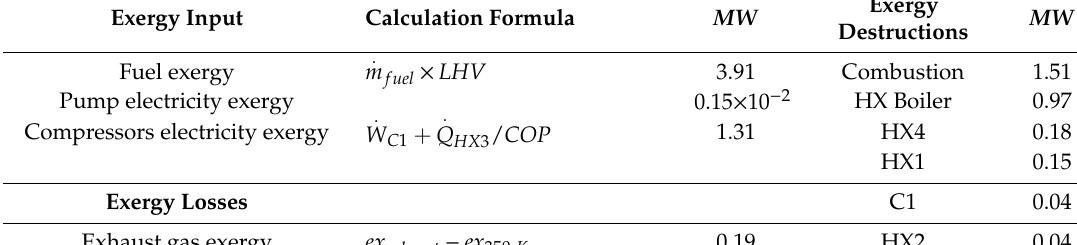
Figure 8. Flow diagram of the pinch-optimal HEN of the case study (case 1).